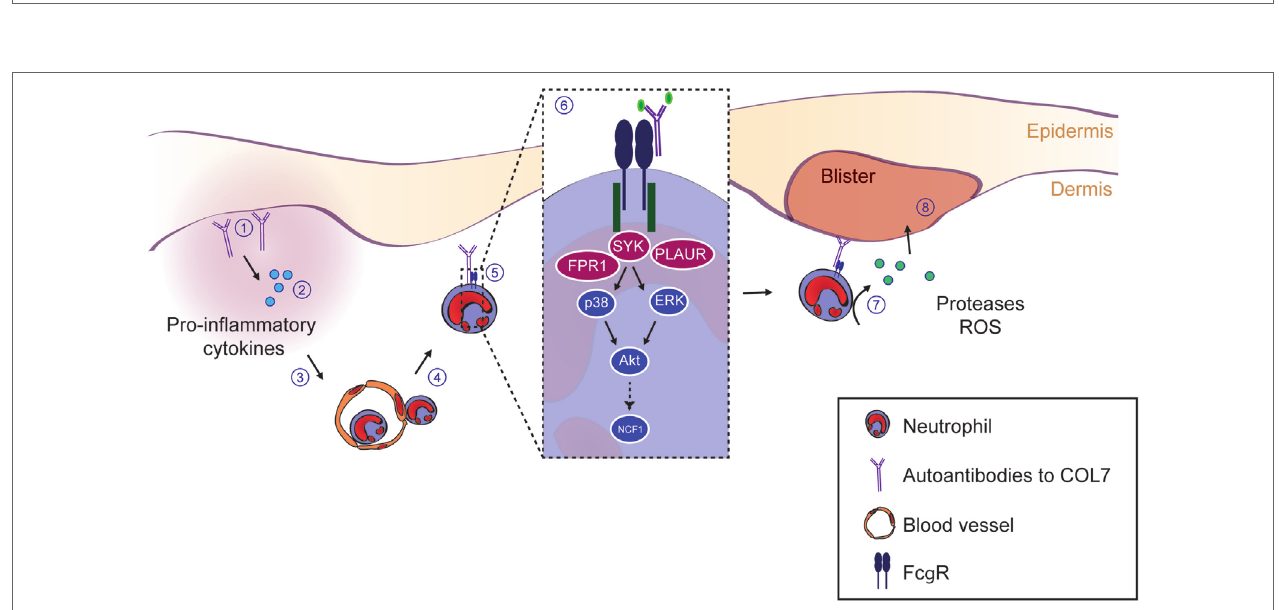
FigUre 8 | Plaur and formyl peptide receptor 1 ( Fpr1 ) are regulated by SYK in immune complex-activated murine neutrophils. (a) Neutrophils were activated by immune complexes in absence or presence of BAY-61-3606 (BAY). Solvent and resting cells served as controls. Plots represent the expression of indicated gene in relation to Gapdh . Because of the non-parametric distribution, data are presented as median (centered vertical line), 25/75-percentile (boxes), and the 5/95-percentile (bars). Data are based on 8–10 samples per group. Statistical analysis was performed using ANOVA Ranks with the Student–Newman–Keuls post-test. (B) mRNA expression of Sykb , Gr-1 , Plaur , and Fpr1 were determined in the skin of healthy mice (NR-IgG) and mice with experimental epidermolysis bullosa acquisita (EBA) (anti-type VII collagen IgG). For expression analysis, skin specimens from corresponding areas were obtained. Myeloid cell infiltration, mirrored by an increase in Gr-1 expression, was accompanied by an increased expression of Sykp , Plaur , and Fpr1 . Data are based on five mice per group. Statistical calculations were performed using Rank Sum test. (c) Western blot analysis of SYK and GAPDH expression in the same samples of immunization- induced EBA and normal mouse skin. SYK expression could, in most cases, be detected only in lesional skin—with very few SYK expression in healthy skin. The graph shows the relative amount of the mean gray value (MD) of the SYK bands per GAPDH bands. Here representative blots are shown. (D) Quantitative analysis of the Western blots from five mice per group ( t -test).